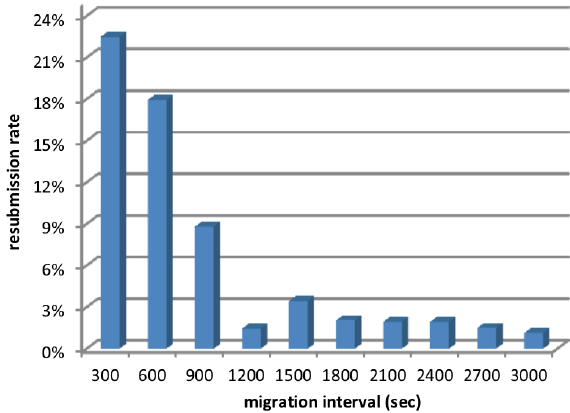
Figure 8. Reduction of packet resubmission rates by increasing the migration intervals [17].